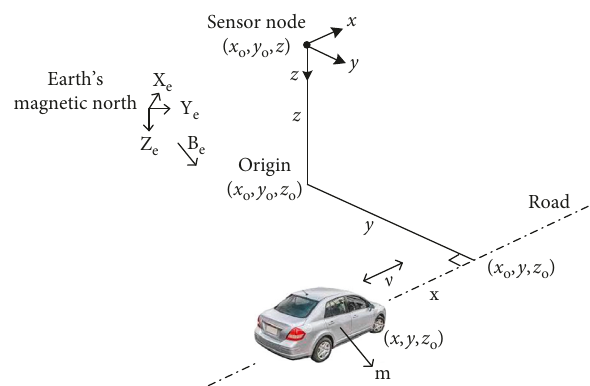
Figure 3: Model formation showing wireless sensor node location with respect to the origin, total Earth’s magnetic field and its components, wireless sensor node and its directions, road link, and a moving